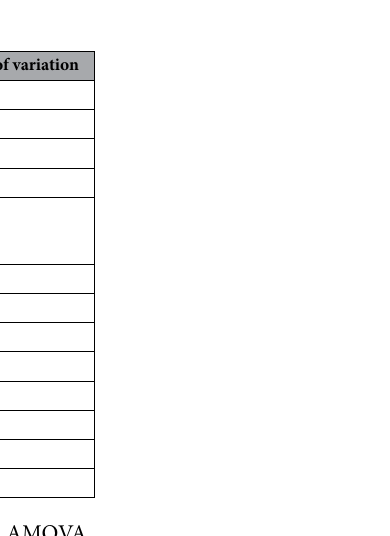
Table 4. Distribution of genetic diversity obtained from